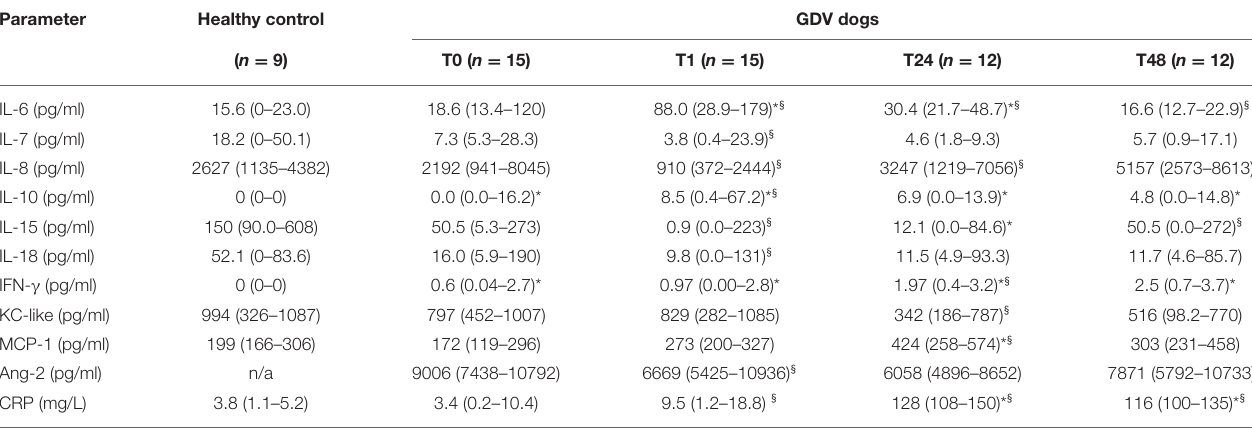
TABLE 2 | Median (interquartile range) concentrations of inflammatory markers at admission (T0), post-surgery (T1), 24h (T24), and 48h (T48) post-surgery in dogs with gastric dilatation volvulus (GDV) and in healthy control dogs. Parameter